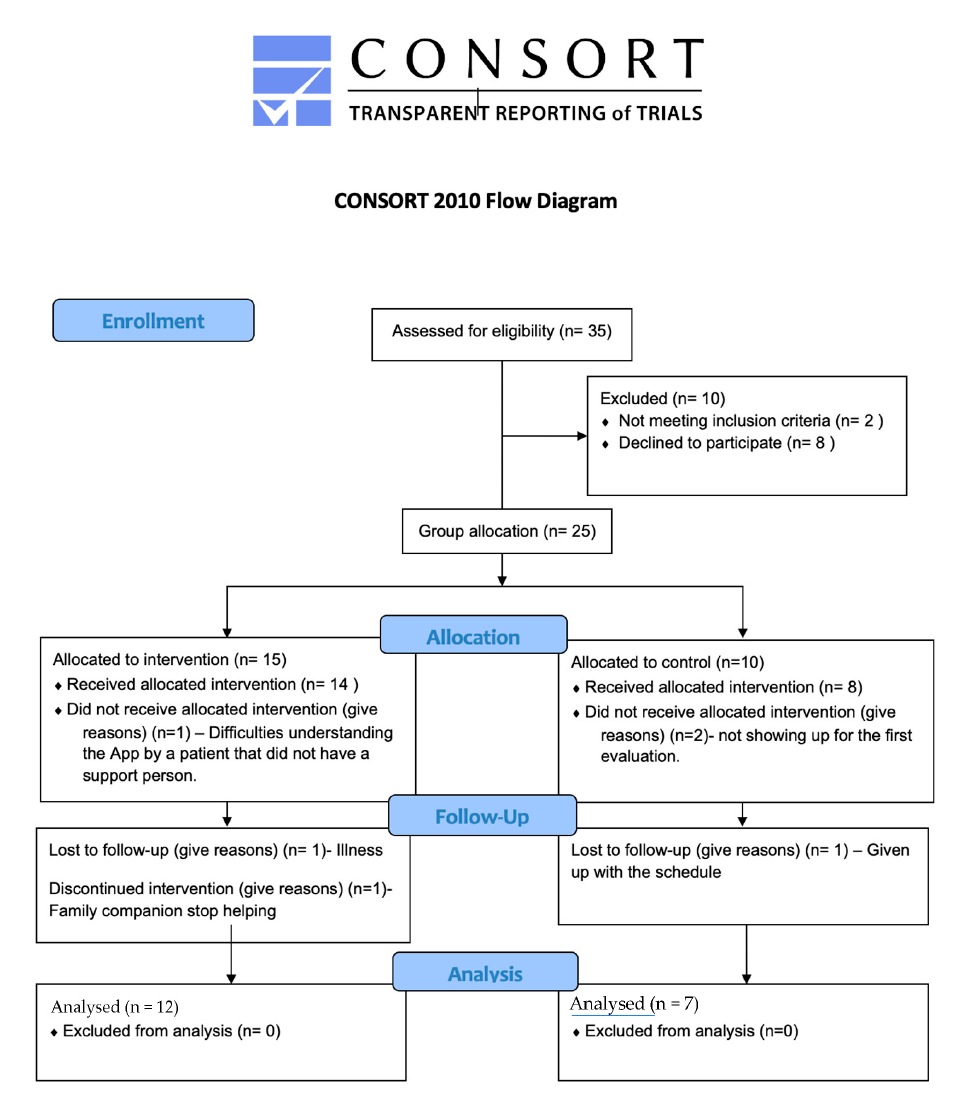
Figure 1. Flow diagram of the subject’s recruitment and participation. Inclusion requirements: (i)